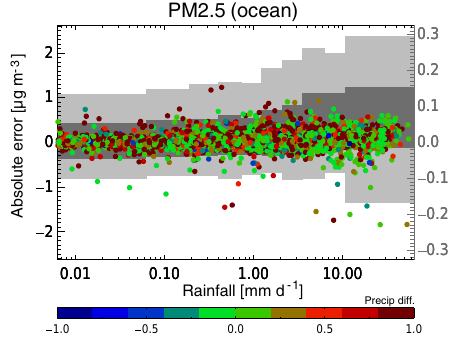
Figure 24. Impact on daily representation errors from precipitation. The symbols use the left-hand axis (colours indicate relative differ- ence in precipitation between observation and wider area), the grey quantile boxes the right-hand axis. Results for a 210 × 210km 2 grid box for Ocean.